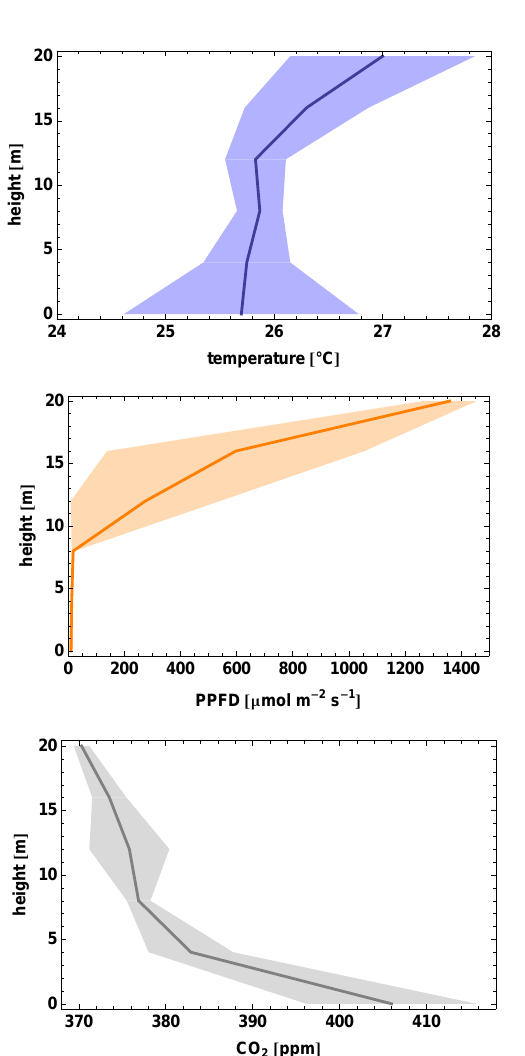
Fig. 1. Example of key environmental drivers for isoprene and monoterpene emissions from forest canopies in summer. Air tem- perature, quantum flux density (PPFD) and ambient CO 2 mixing ratio have been measured on the 12 August 2010. The lines denote mean values and the shaded areas the standard deviations. Means have been averaged over the period of BVOC measurements.